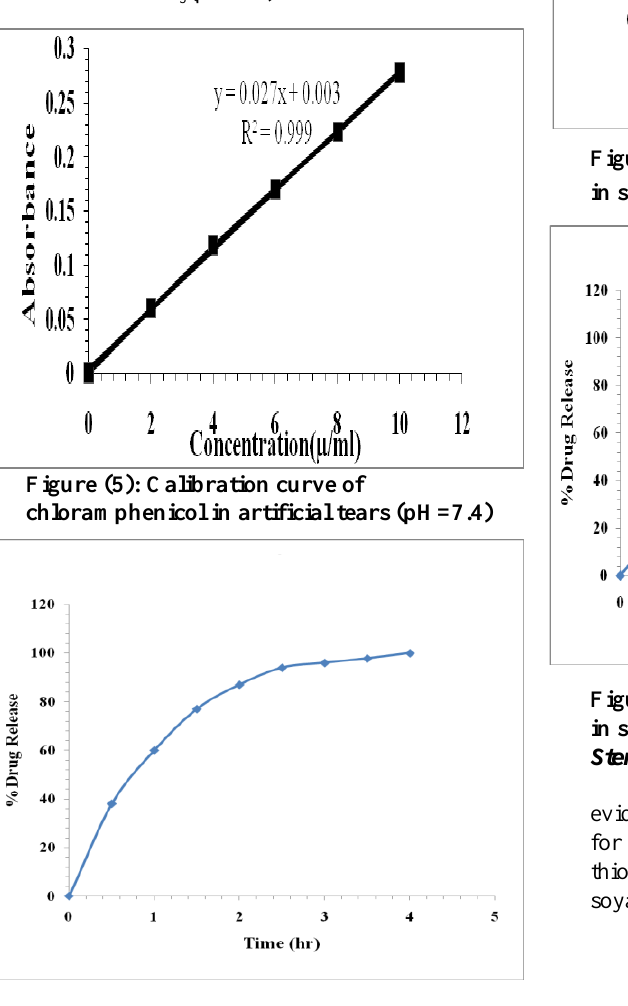
Figure (6): The release profile of formula 2 in simulated tear fluids at 37 0 C. Formula